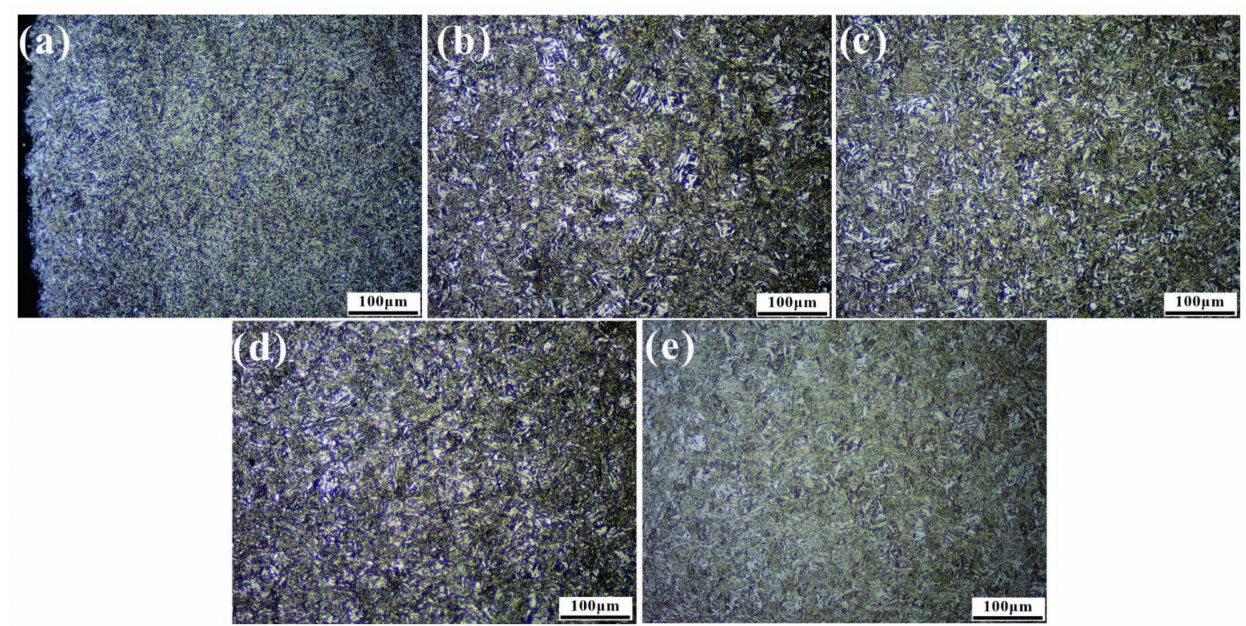
Figure 10. OM microstructure of 20Cr2Ni4A steel C-ring specimens at different locations: ( a ) Node 1, ( b ) Node 2, ( c ) Node 3, ( d ) Node 4 and ( e ) Node 5.